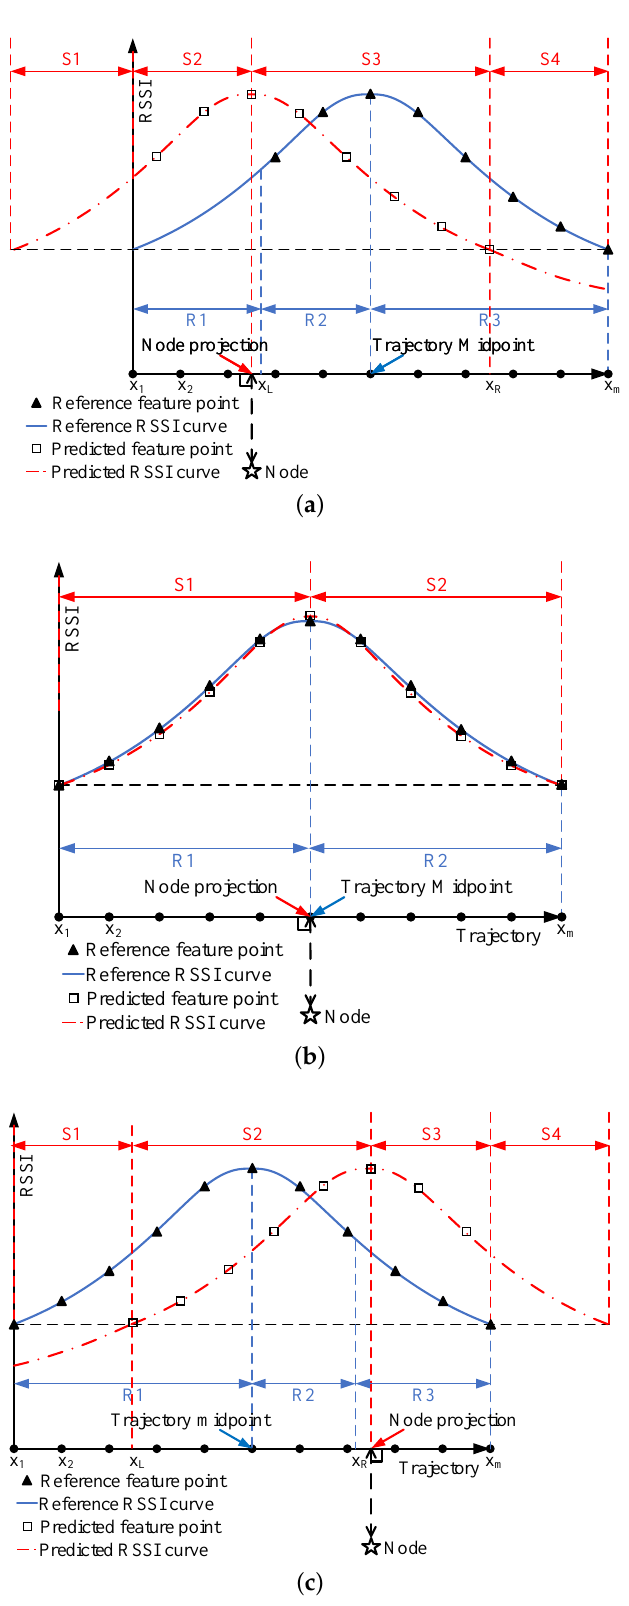
Figure 8. Three positional relationships between the projection of the node and the midpoint of the trajectory: ( a ) the projection of the node is on the left of the midpoint; ( b ) the node projection coincides with the midpoint; and ( c ) the projection of the node is on the right of the